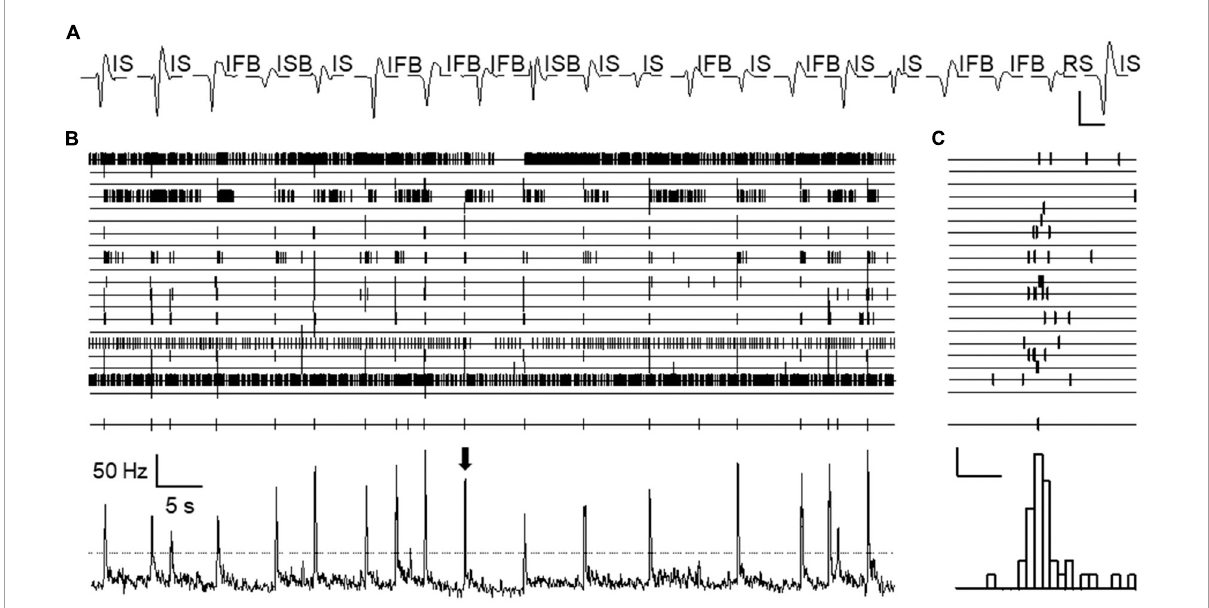
FIGURE2 Population bursts observed during spontaneous activity. (A) Shows sorted spike forms from an experiment. Twenty spike forms were isolated, presumably generated by 20 different neurons. Each trace is an average of all spikes belonging to each isolated unit during the whole length of the experiment. Patterns of spontaneous activity are displayed for each spike using acronyms defined in text. Calibration bars 0.2 mV and 2 ms. Channels 1–20 (from top to bottom) in panel (B) show time stamps for each action potential fired by each neuron as sorted in panel (A) (from left to right) recorded during an approximate period of 1 min. All time stamps were collapsed into a single channel and represented as mean frequency (bottom channel). Peaks in this channel show the occurrence of “population bursts.” Threshold for population burst detection in this experiment is indicated by the discontinuous line. Time marks for bursts are shown just above. (C) Shows in expanded time base, the firing of each neuron during a single population burst (marked by arrow in panel B ). The lower panel shows a combined frequency histogram and just above it, the burst mark placed at the time of maximum firing frequency. Calibration bars 2 action potentials and 100